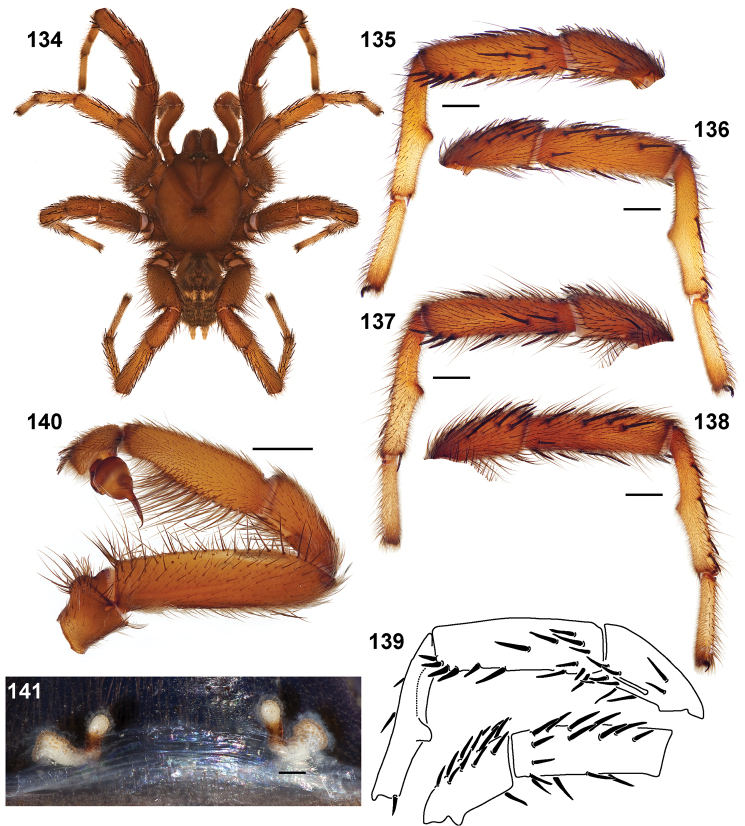
Aptostichus nateevansi sp. n. from Los Angeles Co., Santa Catalina Island (holotype) and San Clemente Island (paratype). 134–136, 139, 140 male holotype (AP420); scale bars = 1.0mm 134 habitus [805860] 135 retrolateral aspect, leg I [805854] 136 prolateral aspect, leg I [808858] 137, 138 male paratype (AP429) 137 retrolateral aspect, leg I 138 prolateral aspect, leg I 139 line drawings of leg I spination patterns, retrolateral aspect of patella, tibia and metatarsus and prolateral aspect of patella and tibia 140 retrolateral aspect, pedipalp [805864] 141 cleared spermathecae (AP543) [806576]; scale bar = 0.1mm.